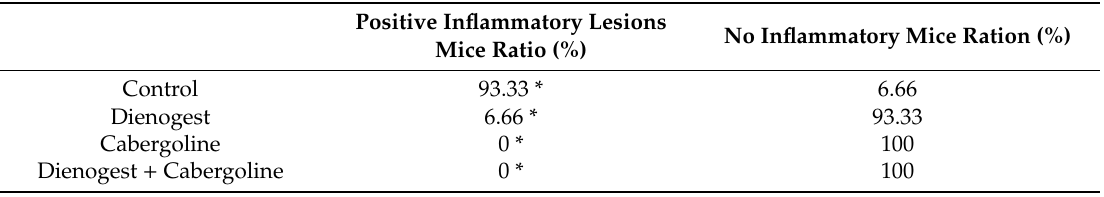
Table 2. The number of inflammatory lesions positive and no inflammatory mice ratios.